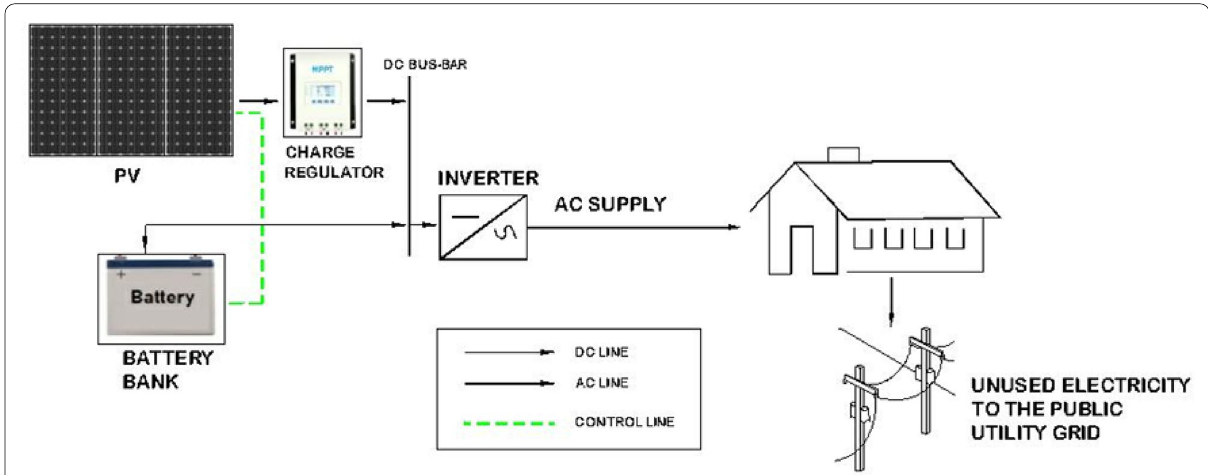
Fig. 12 The block diagram of the proposed PV system for Kathmandu